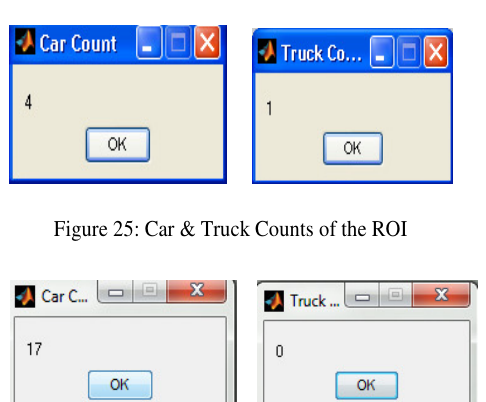
Figure24: SPOT-5 Panchromatic Image (2.5m) & ROI